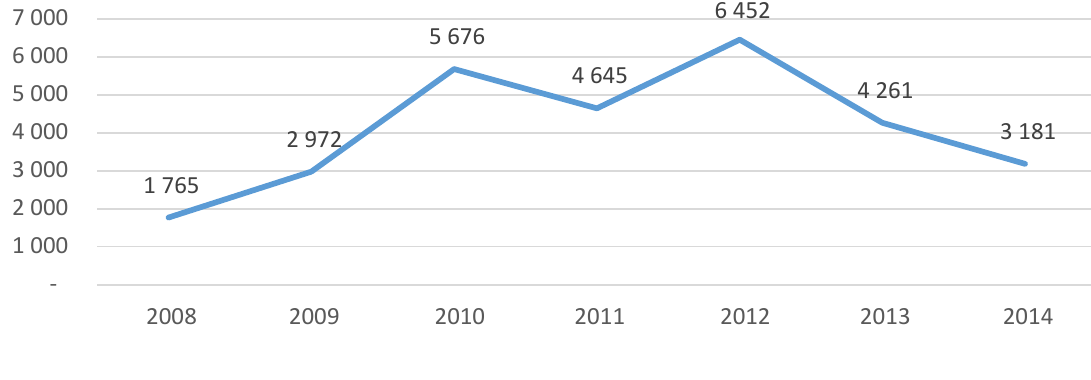
Figure 1. Customer development BLUD of Kendari city micro credit